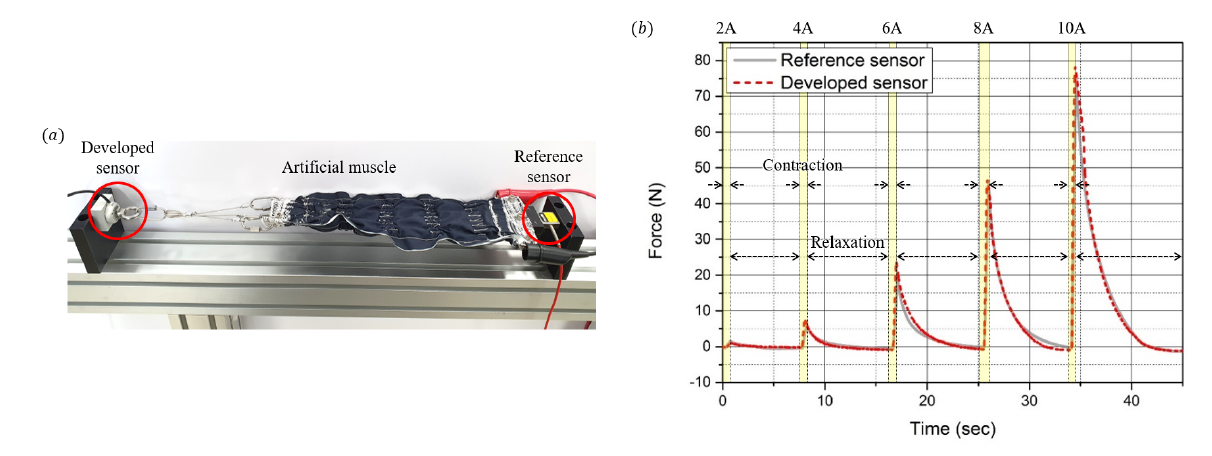
Figure 16. Performance tests with the sensor integrated to an artificial muscle actuator. ( a ) Experimental setup composed of the developed sensor, reference sensor, and an artificial muscle. ( b ) Resulting force of the artificial muscle measured by the developed sensor (red dot) and the reference sensor (black